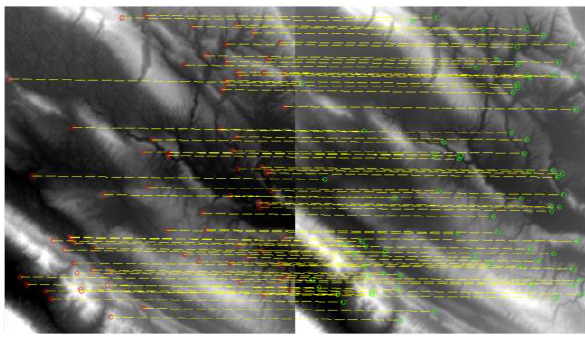
Figure 4. SIFT + RANSAC matching method